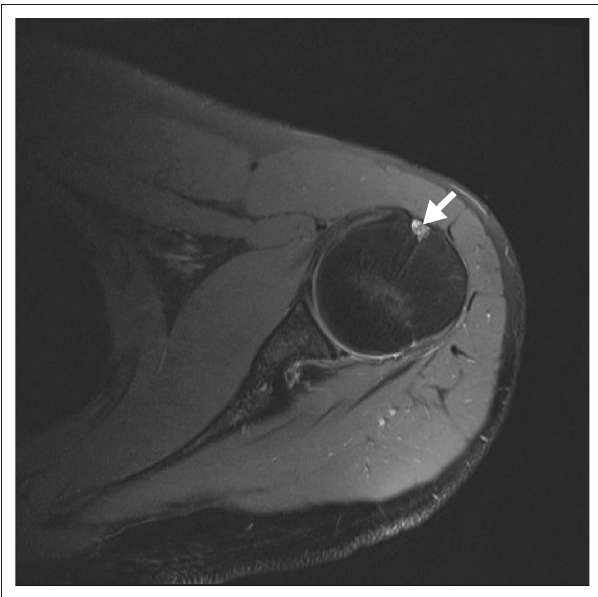
FIGURE 1: Magnetic resonance image (MRI) PD TSE FS in the axial plane, demonstrating an empty bicipital groove (arrow).